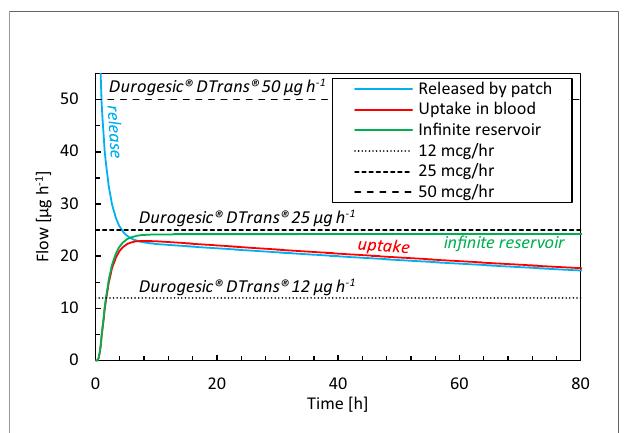
FIGURE 4 | Drug fl ow as a function of time for drugs released by the patch (g pt,rel ), for drugs taken up by the blood fl ow (g bl,up ) for the base case and commercial fentanyl patches. The results of an in fi nite reservoir are